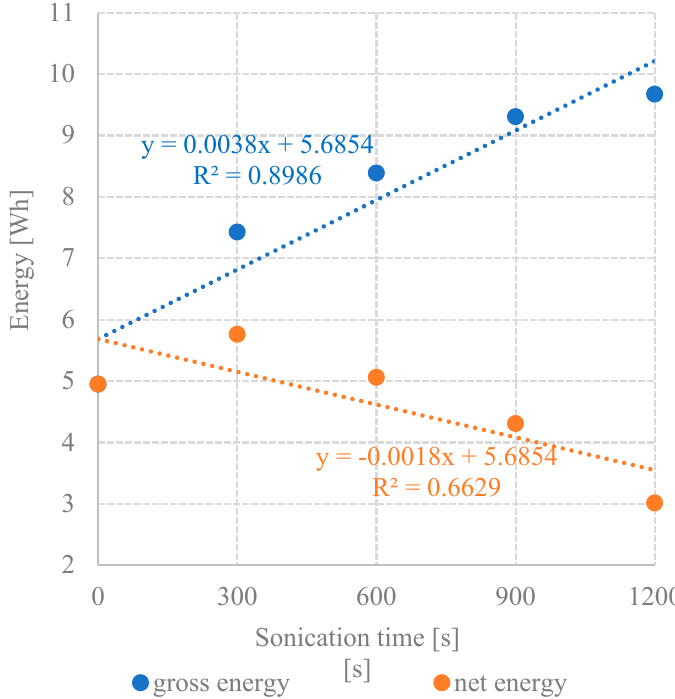
Figure 16. Correlation between UD time and gross and net energy effects.